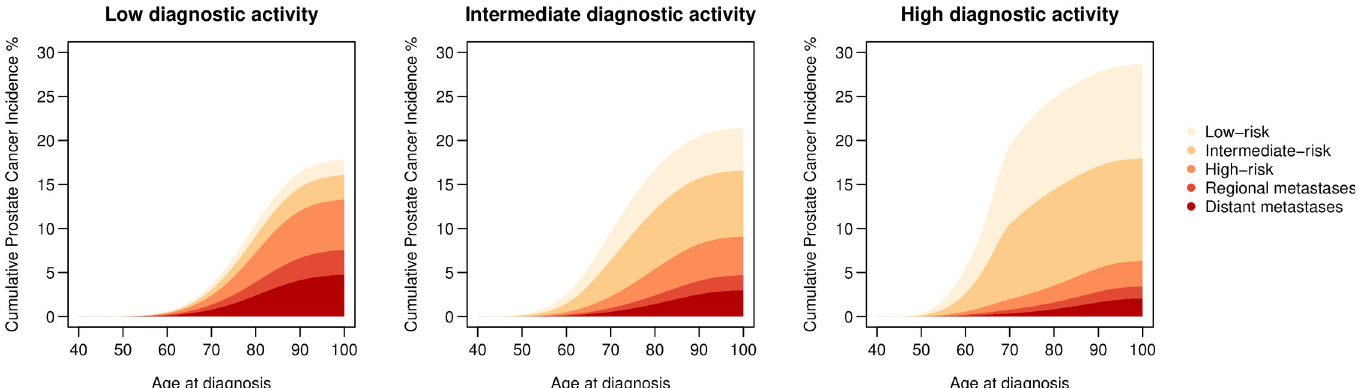
Fig 1. Cumulative incidence of prostate cancer diagnosis by risk category for a simulated follow-up of 2,000,000 men from age 40 to age 100 under three different levels of diagnostic activity: Low as in Sweden 1992; Intermediate as in Sweden 2016; High as in Stockholm 2014; when the Stockholm-3 study invited men to measure their PSA